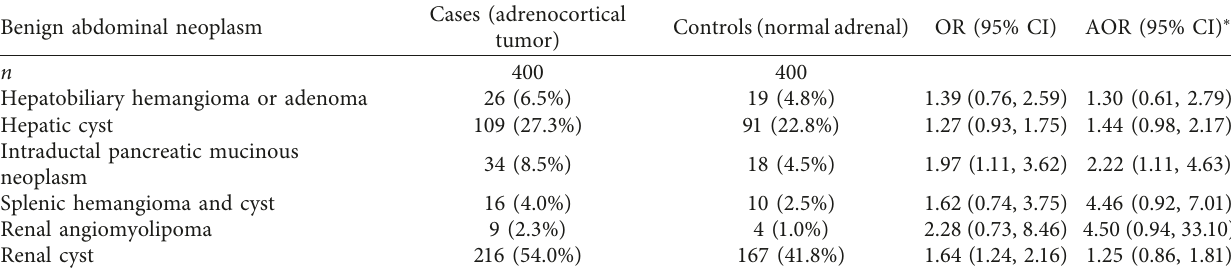
Table 4: Risk for benign abdominal neoplasia detected via abdominal cross-sectional imaging.